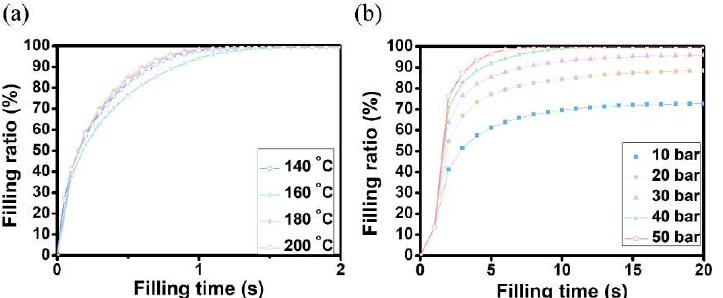
Figure 12. Relationship between mold filling time and filling ratio for ( a ) rectangular mold; ( b ) au- tomotive hood. motive